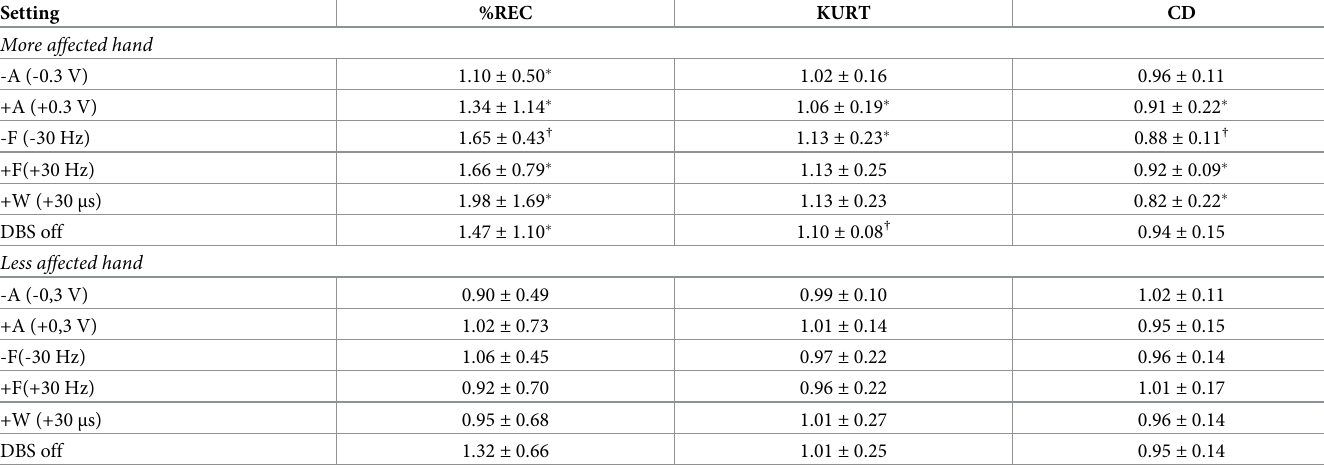
Table 3. Relative EMG signal parameters recurrence rate (%REC), kurtosis (KURT), and correlation dimension (CD) (median ± IQR). %REC changed significantly after each adjustment. Increasing voltage or decreasing frequency of the stimulation changed each parameter significantly. Significance levels � p < 0.05, † p < 0.01. Setting %REC KURT CD More affected